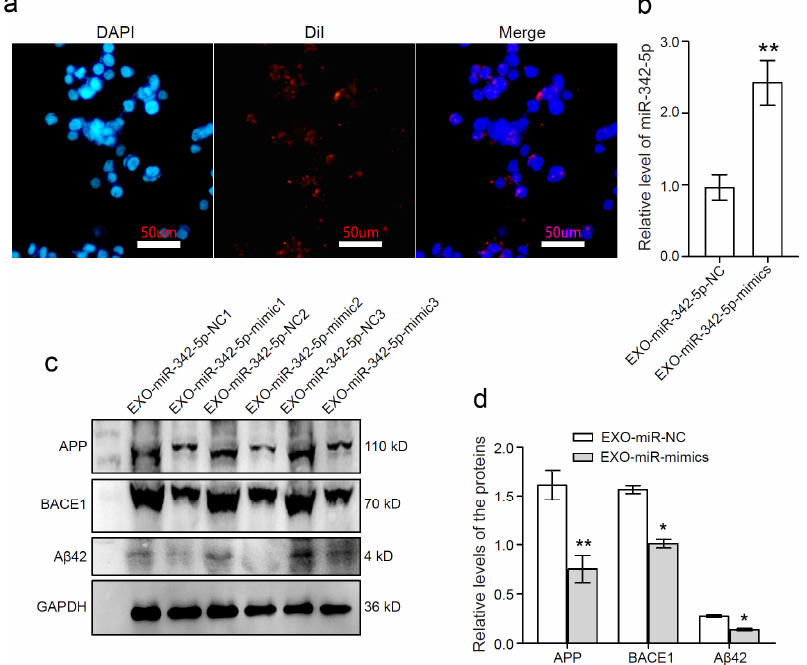
Figure 4. Enrichment of miR-342-5p ameliorated A β pathology evoked by Exo-APP in mouse hip- pocampal HT-22 neurons. ( a ) The internalization of Dil-labeled sEVs into HT22 cells was visualized using a Nikon fluorescent microscope. DAPI staining was used to detect cell nuclei. Scale bars represent 50 µ m. ( b ) Exo-APP were transfected with miR-342-5p mimics (EXO-miR-mimics) or its negative control (EXO-miR-NC), respectively. The levels of miR-342-5p in the sEVs were evaluated using qPCR. **, p < 0.01. ( c ) HT22 cells were treated with the sEVs enriched with miR-342-5p mimics (EXO-miR-mimics) or its negative control (EXO-miR-NC). APP, BACE1, and A β 42 proteins in HT22 cells incubated with EXO-miR-mimics or EXO-miR-NC were detected using Western blot assay. The experiments were performed in triplicate. ( d ) Relative levels of APP, BACE1, and A β 42 in HT22 cells were quantified by densitometry. GAPDH was used as an inner control. *, p < 0.05, **, p <